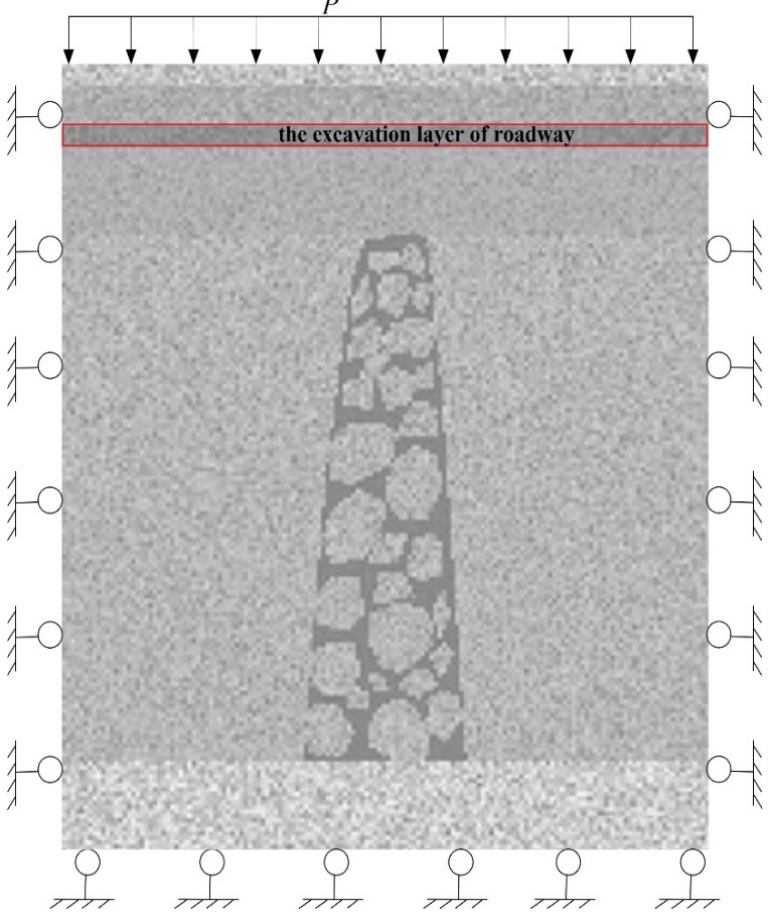
Figure 4. Schematic diagram of numeric model. According to the indoor test results, the properties and mechanical parameters of each rock layer were determined as shown in Table